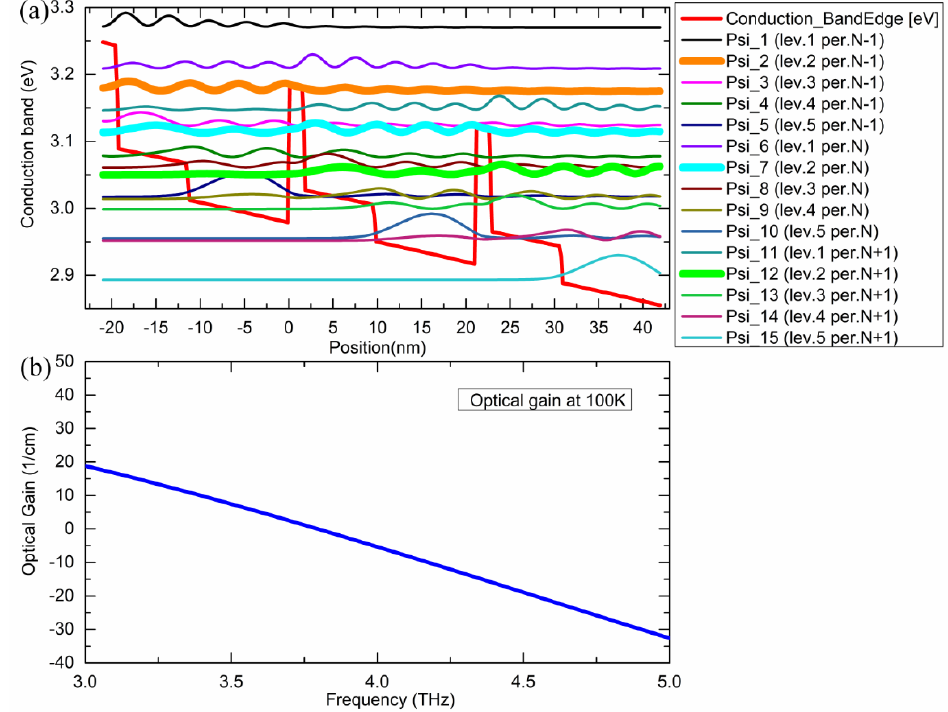
Figure 5. Effect of a parasitic energy level. ( a ) Conduction band diagram of the Q1W test case 2 at 62 mV per period. ( b ) Calculated optical gain of test case 2 with high energy leakage levels at 100 K.